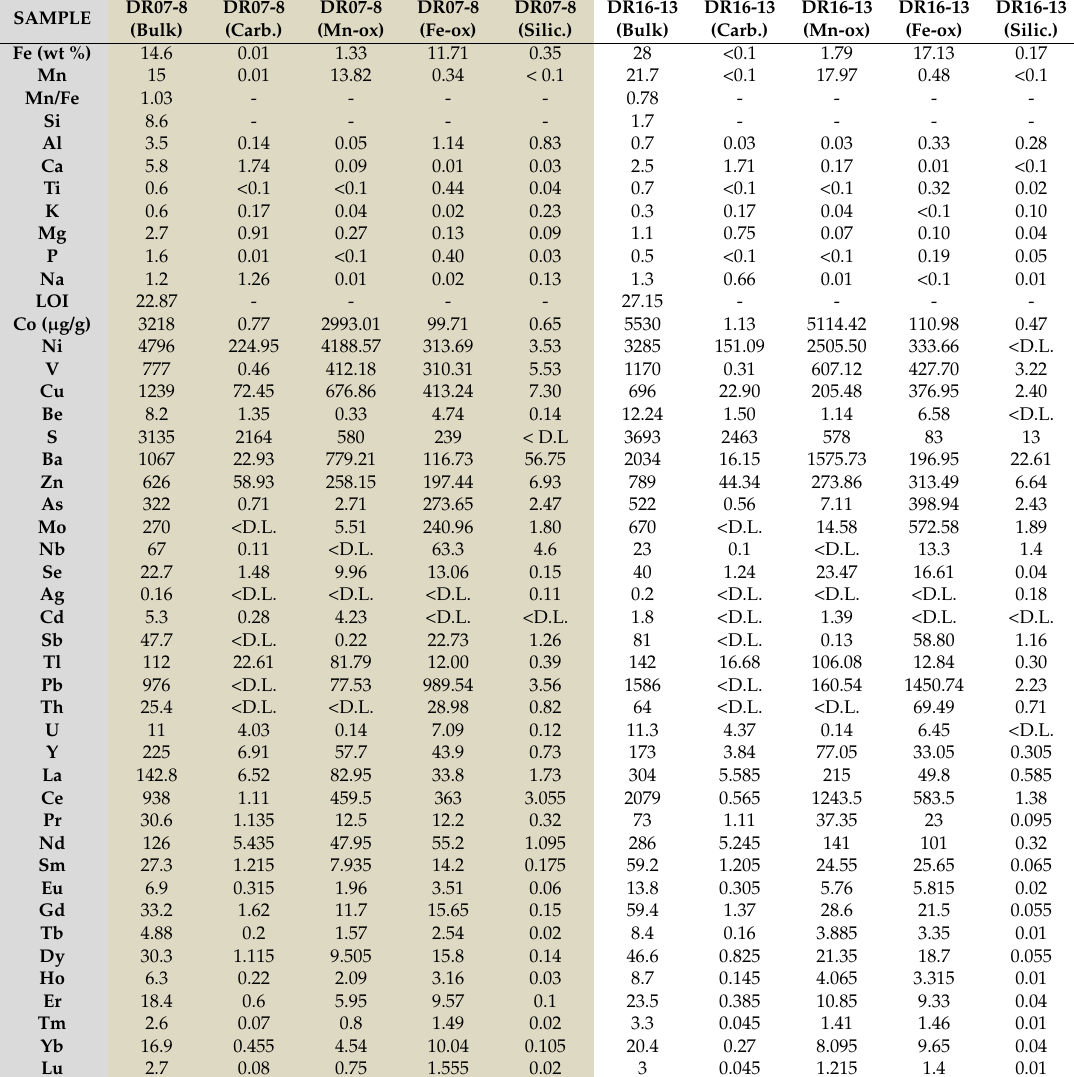
Table 2. Chemical composition of the studied CISP Fe–Mn crusts. Bulk analysis and each sequential leaching fraction extracted during the experiment are represented. <D.L.: below detection limit. -: no data. Carb. = carbnates, Mn-Ox. = Mn-oxides, Fe-ox. = Fe oxyhydroxides, Silic. = silicates. The back color is to differentiate both